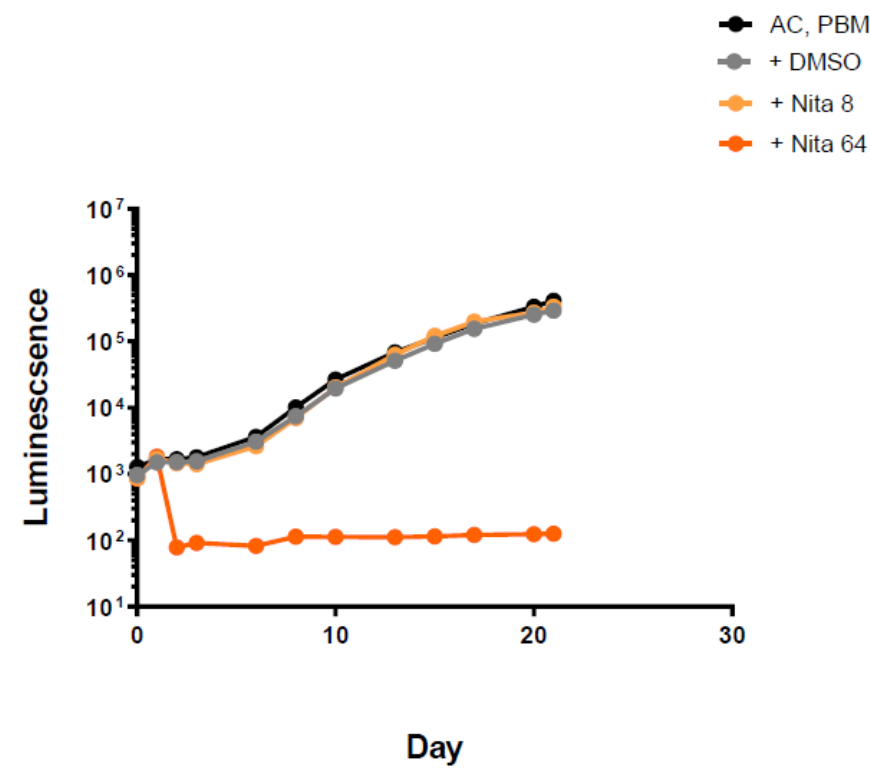
Figure 2. Luminescence detection at different time points for nitazoxanide in TB-infected PMBCs obtained from donor 1. AC: alginate collagen; PMBCs: peripheral blood mononuclear cells; Mtb: Mycobacterium tuberculosis; DMSO: dimethyl sulfoxide; Nita8: Nitazoxanide 8 mg/L; Nita 64: Nitazoxanide 64 mg/L.